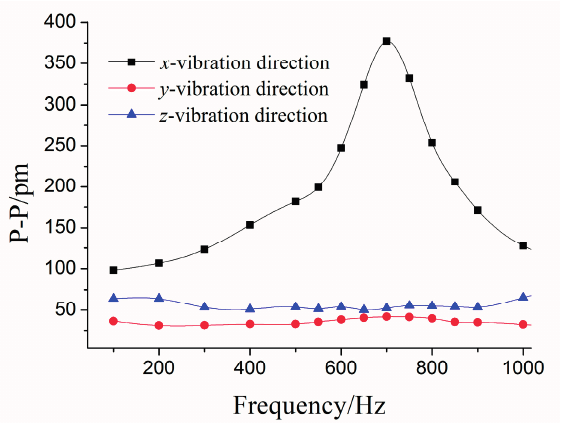
Figure 7. Amplitude-frequency curve of the sensor for the x -vibration direction.